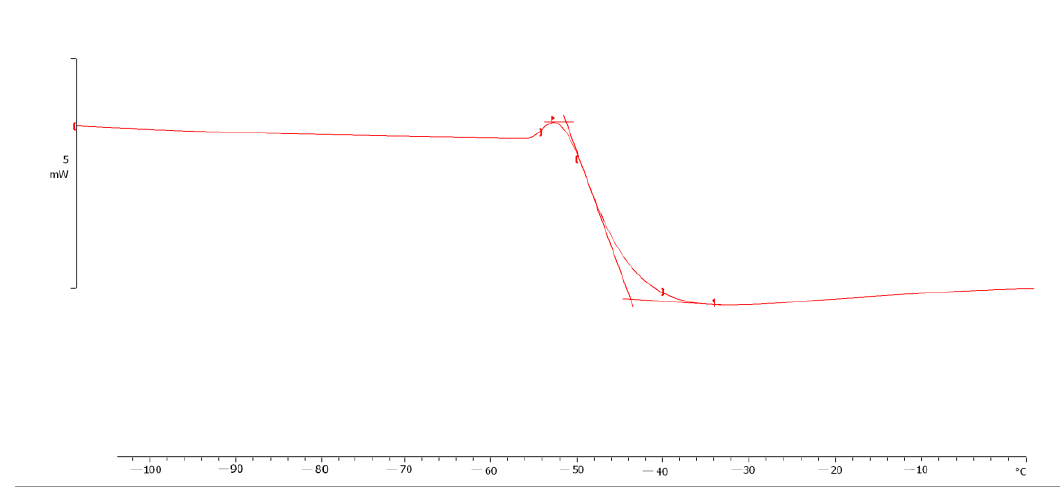
Figure 1. DSC thermogram of PVC composition with BBEA.